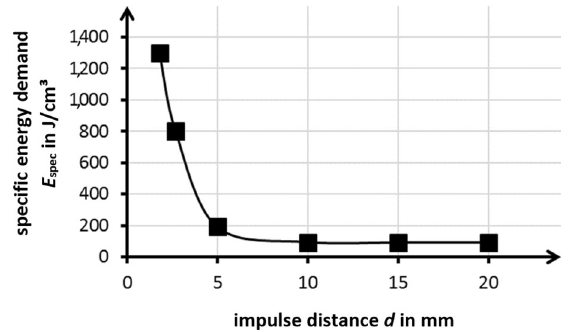
Fig. 11 Specific energy E as a function of the horizontal distance spec d between the